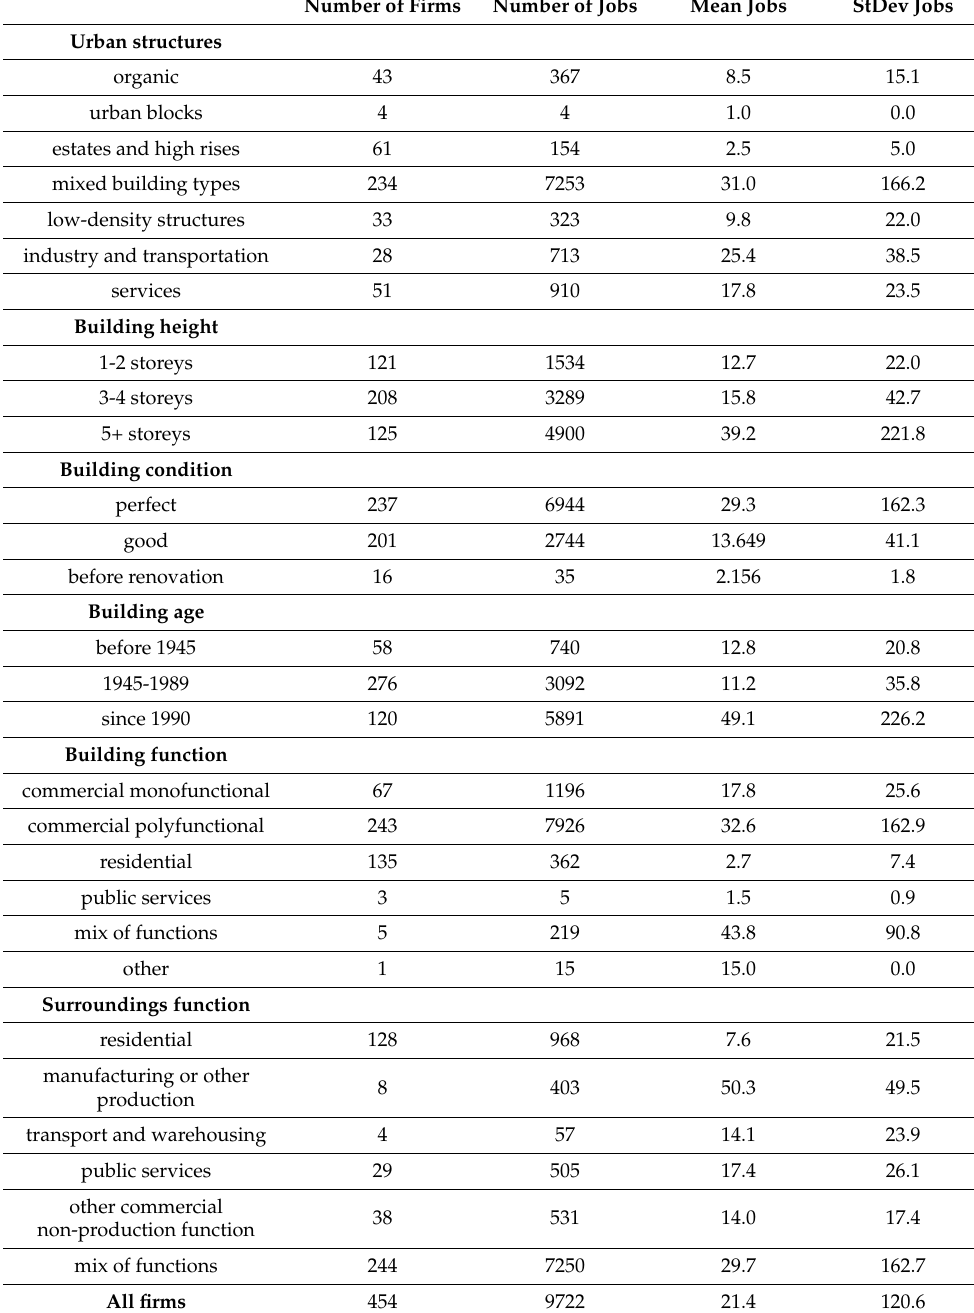
Table 2. ICT firms in Ostrava and urban forms: descriptive